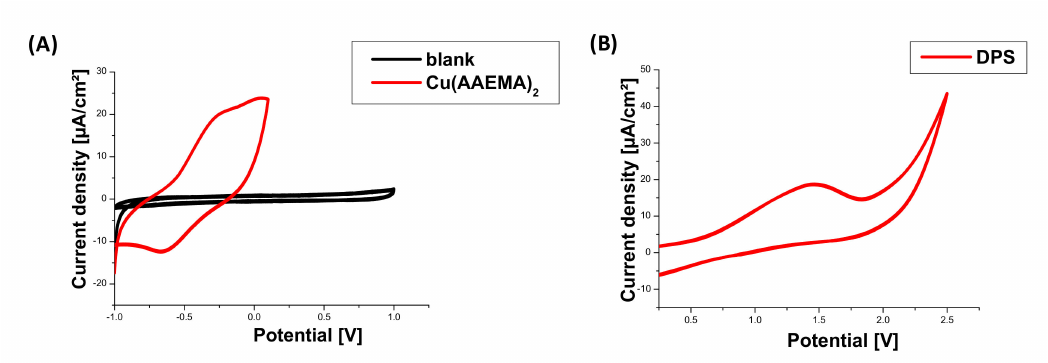
Figure 7. Cyclic voltammetry (potential vs. saturated calomel electrode (SCE)) experiments in acetonitrile (ACN) (containing 0.2 M tetrabutylammonium hexafluorophosphate, 0.1 V / s) for the